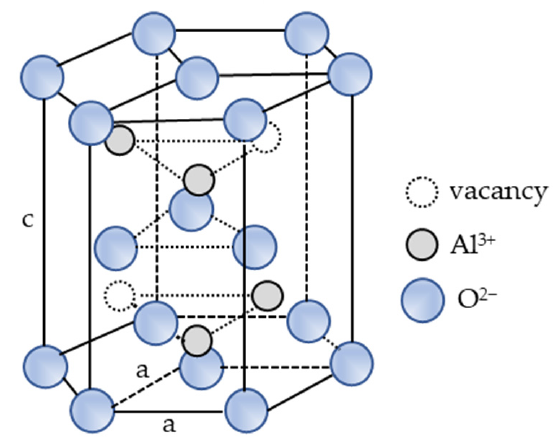
Figure 7. Corundum structure of alpha-alumina ( α -Al 2 O 3 ). Table 8. Ionic radius of cations present in Al 2 O 3 [51].